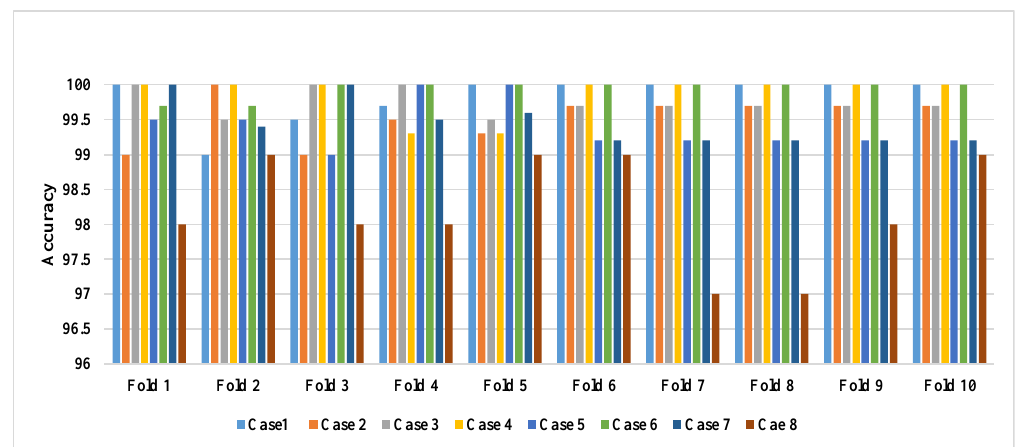
Figure 5. The performance of the proposed Cov–Det-based AB–BP–NN model using the ten-cross validation procedure.